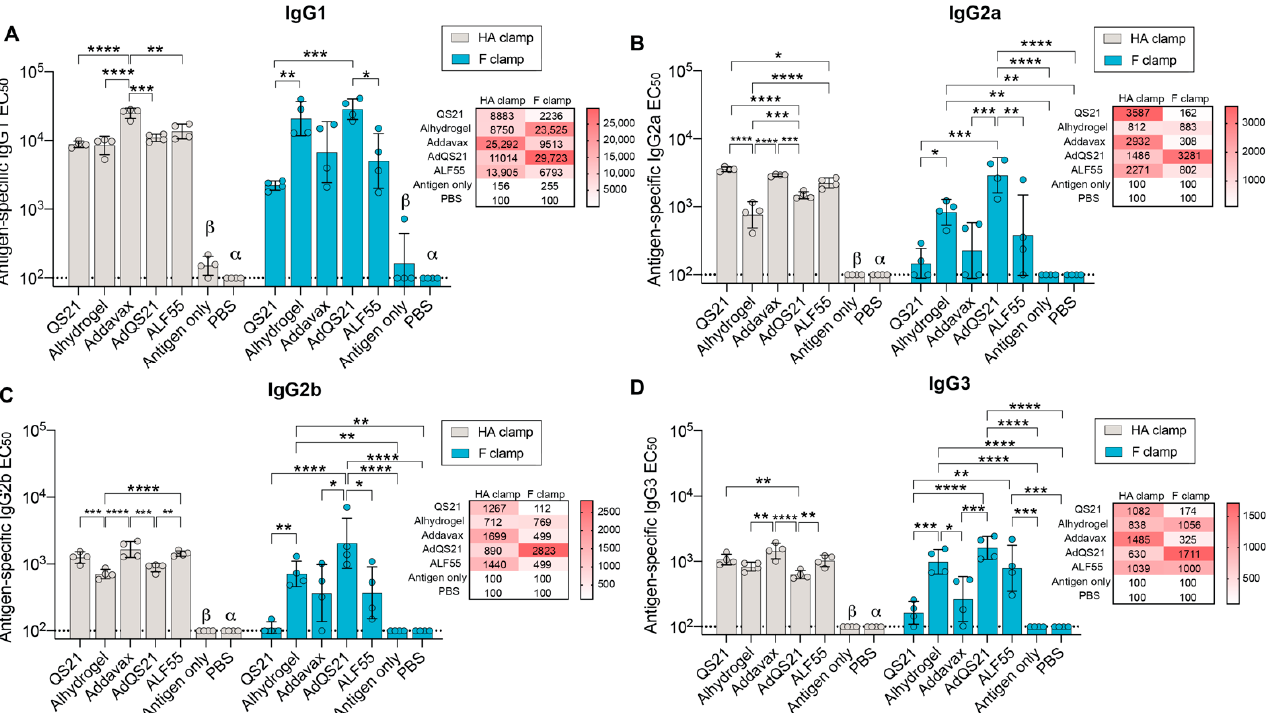
Figure 2. Antibody isotyping of mouse sera post antigen immunization with various adjuvants. Data shown is from the final terminal bleed. Sera from individual mice ( n = 4) were isotyped by ELISA against the vaccine antigen with secondary antibodies specific for mouse IgG1 ( A ), IgG2a ( B ), IgG2b ( C ), and IgG3 ( D ) with PBS background subtracted. Data represents geometric mean with geometric SD. Dotted line shows limit of detection. A heat map is shown for each isotype, with values representing means of each group. Statistics calculated using a one-way Tukey’s multiple comparison ANOVA, where * indicates a p < 0.05, ** p < 0.005, *** p < 0.0005, and **** p < 0.0001; β = p < 0.0005 compared to all groups except PBS, and α = p < 0.0001 compared to all groups unless otherwise specified.